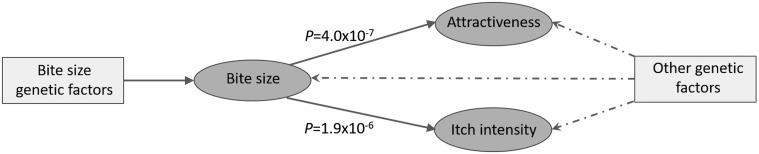
Causal relationships between the three mosquito-related traits. Evidence provided by Egger regression revealed a high degree of overall pleiotropy between all three traits, and also suggested bite size may have a causal relationship on attractiveness to mosquitoes and itch intensity. P; slope coefficient significance level.